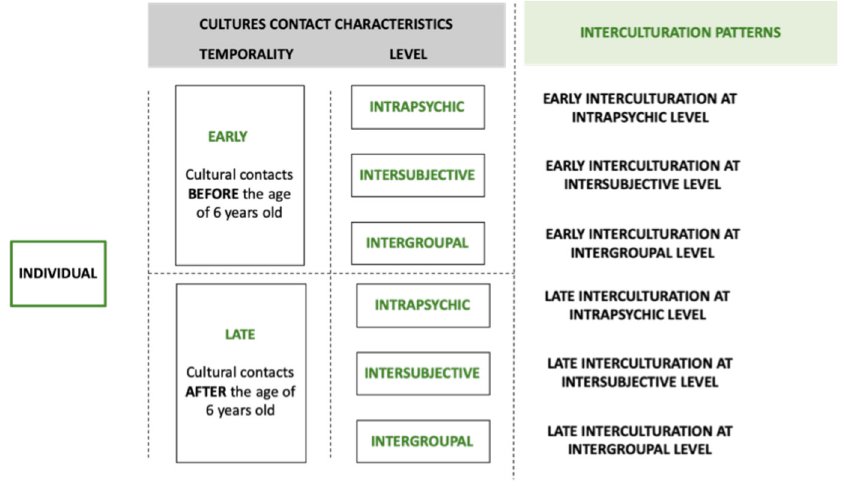
Figure 1. Interculturation patterns according to temporality and the level of contact between cul- tures.